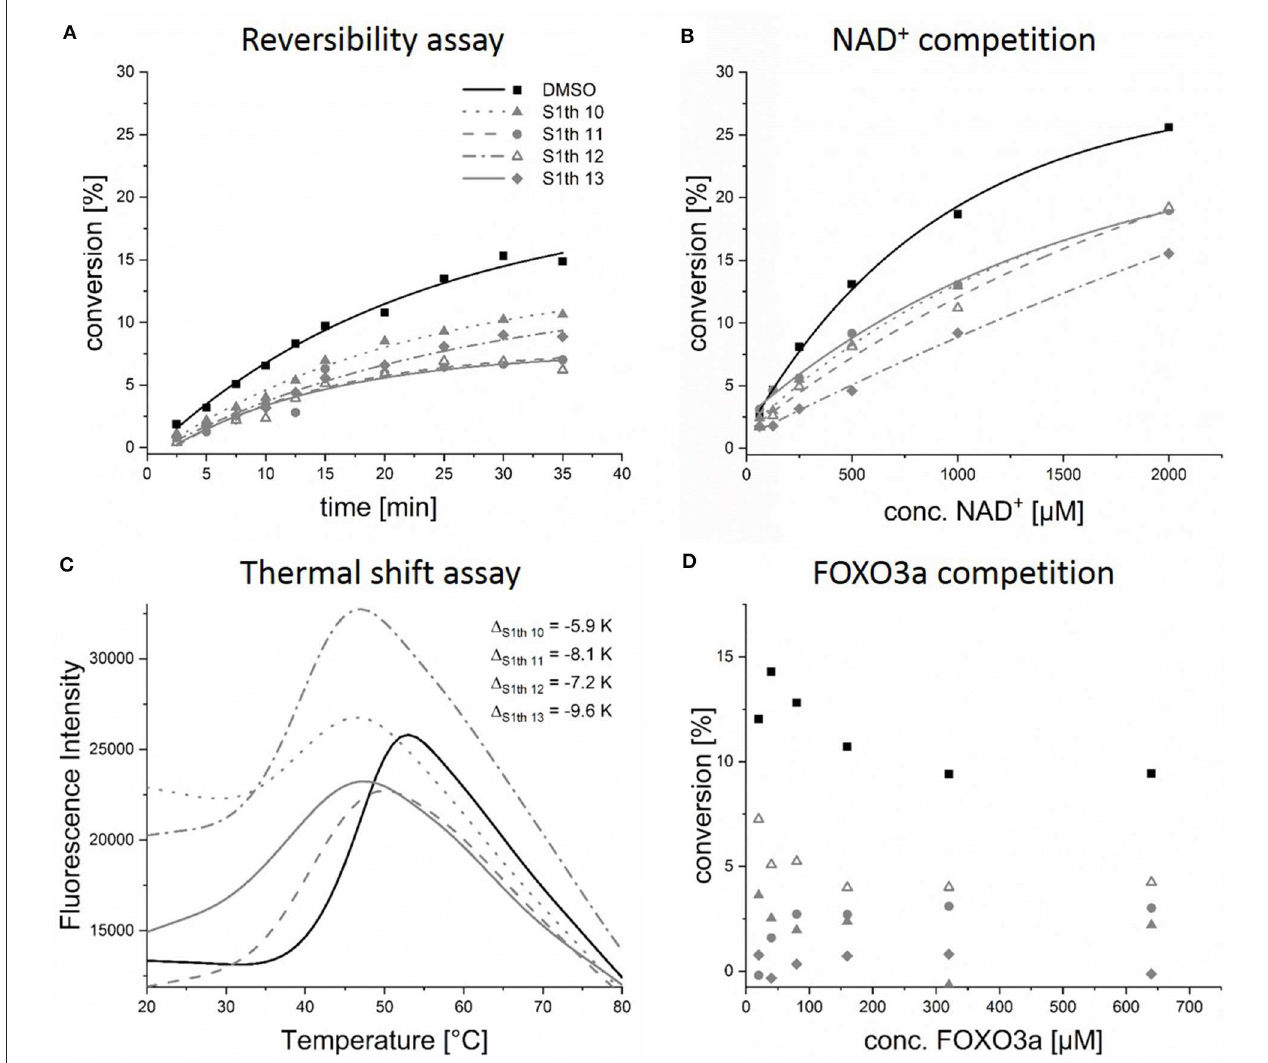
FIGURE 3 | In vitro characterization of the thiocyanates. Evaluation of reversibility, competition with NAD + or the peptide substrate FOXO3a and enzyme stabilization; (A) Sirt1 and the respective thiocyanate inhibitor (50 µ M) were preincubated for 10min and then rapidly diluted 1:100 with assay solution (buffer, ZMAL, NAD + ), activity of Sirt1 was measured at different time points. Increasing activity can be observed for non-covalent inhibitors; (B) thiocyanate inhibitors (100 µ M) were incubated with increasing concentrations of NAD + , showing that the inhibitors can be replaced by NAD + ; (C) binding of S1th 10–13 (100 µ M) to Sirt1 leads to a strong decrease of T m ; (D) S1th (100 µ M) were incubated with increasing concentrations of the peptide substrate FOXO3a, the inhibitors are not competitive toward FOXO3a. All biochemical assays were performed at least twice in